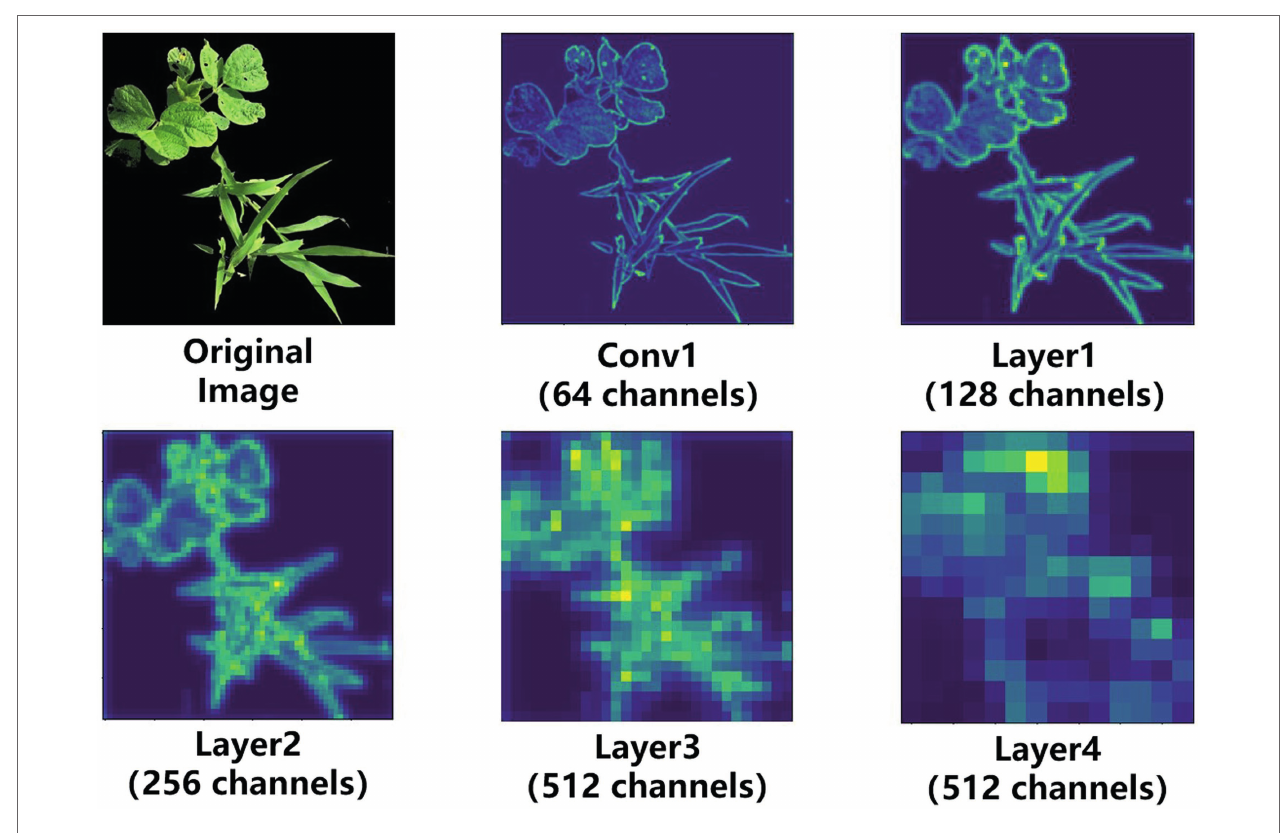
FIGURE 4 | Feature